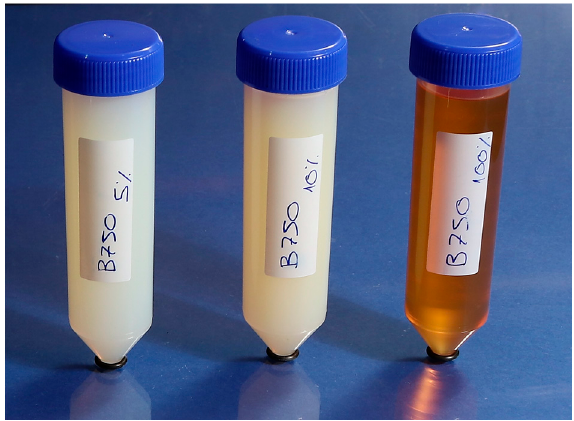
Figure 1. HOCUT B-750 oil-water cutting fluid emulsions with 5%, 10% and 100% oil concentration.